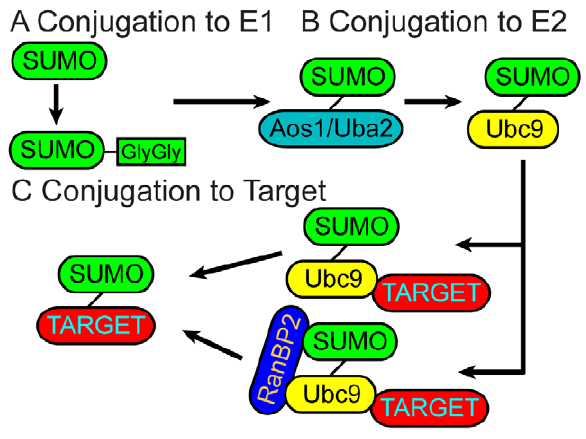
Figure 1. Sumoylation mechanism by E1-E2 and E1-E2-E3 enzymes. (A) Produced as an inactive precursor, the SUMO protein is cleaved, exposing its Gly-Gly motif, and gets activated. (B) Active SUMO is transferred by E1 enzyme Aous1/Uba2 heterodimer to the E2 enzyme Ubc9. (C) Two alternative pathways can follow as the third step. Ubc9 can directly transfer SUMO to specific targets (top). Alternatively RanBP2, an E3 enzyme, can also join the complex, increasing the Ubc9 catalytic activity and transferring SUMO to its targets